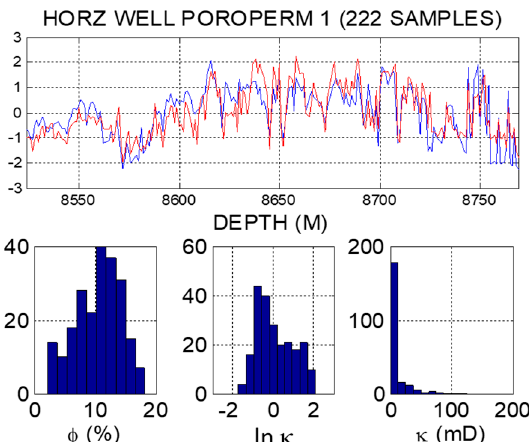
Figure 4. ( Top ) Porosity ( φ , blue) and ln permeability (ln κ , red) measurements from a horizontal well from North Sea clastic oil fields, plotted with zero-mean and unit variance. ( Bottom ) Histograms of the number of measurements in bins of equal porosity, ln κ , or κ .